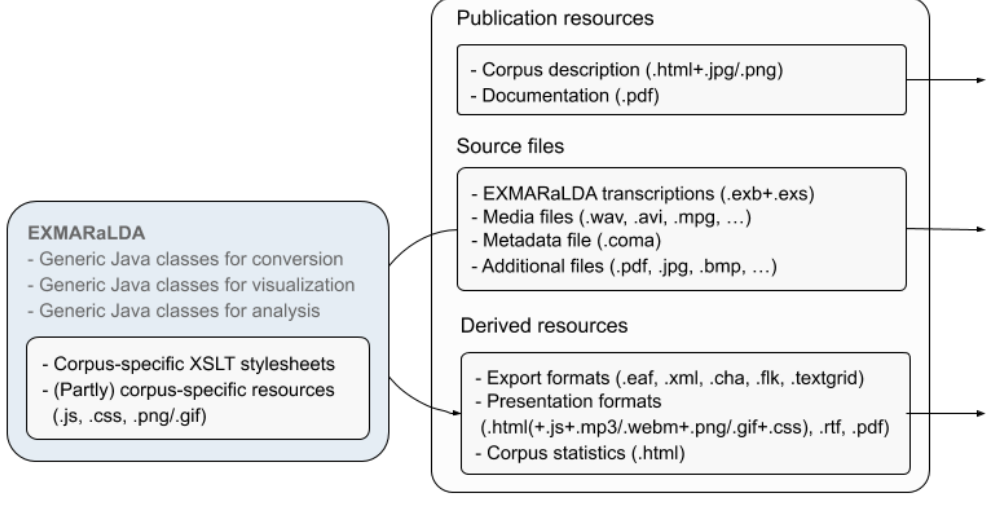
Figure 2. Static website resource